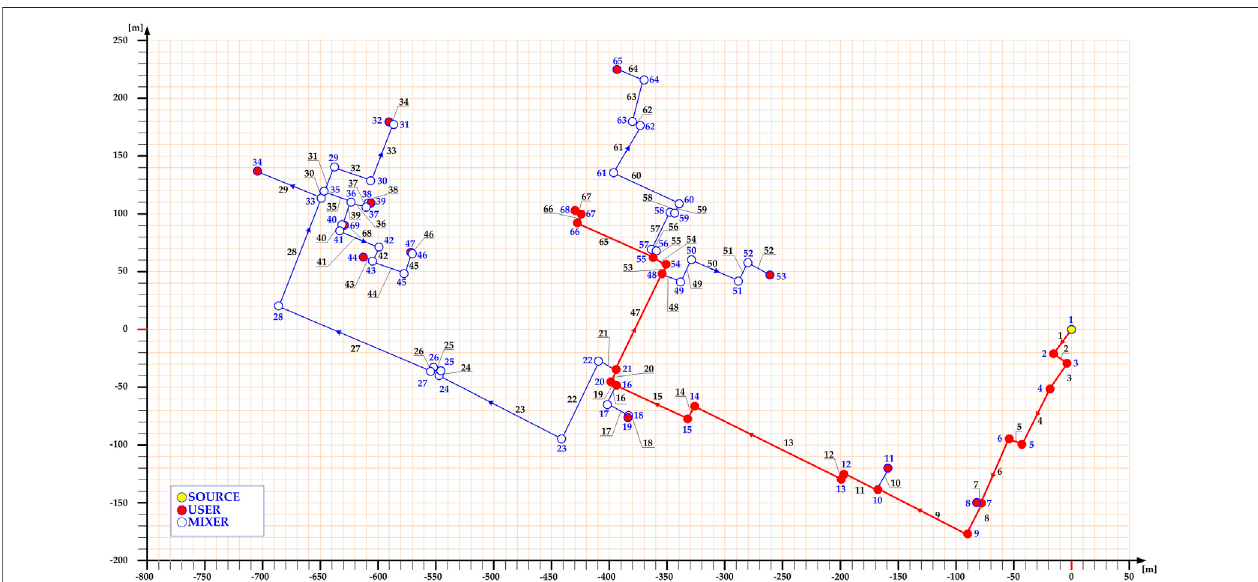
FIGURE 6 | Critical path and fl ow direction of the water within the supply line of the network.